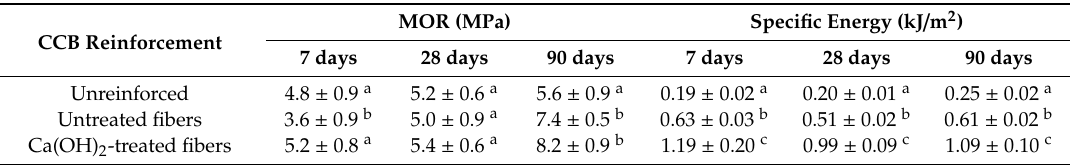
Figure 10. Load–extension curve of various composite cement boards (CCBs) after 7, 28, and 90 days of curing ( a ) CCB without fibers, ( b ) CCB with untreated fibers, and ( c ) CCB with calcium treated fibers. Table 4. Average Modulus of Rupture (MOR) and Specific Energy (SE) of various composite cement boards (CCBs) after 7, 28, and 90 days of curing.